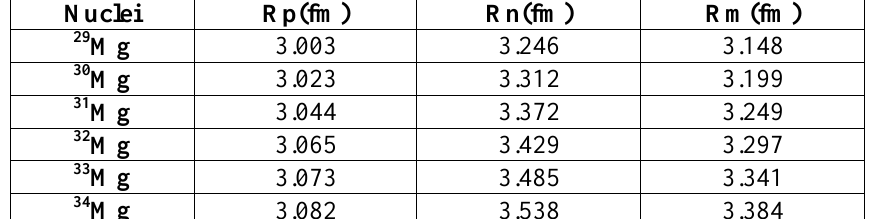
Table 3: The values of radii of protons, neutrons and matter of 29-34 Mg nuclei. Nuclei